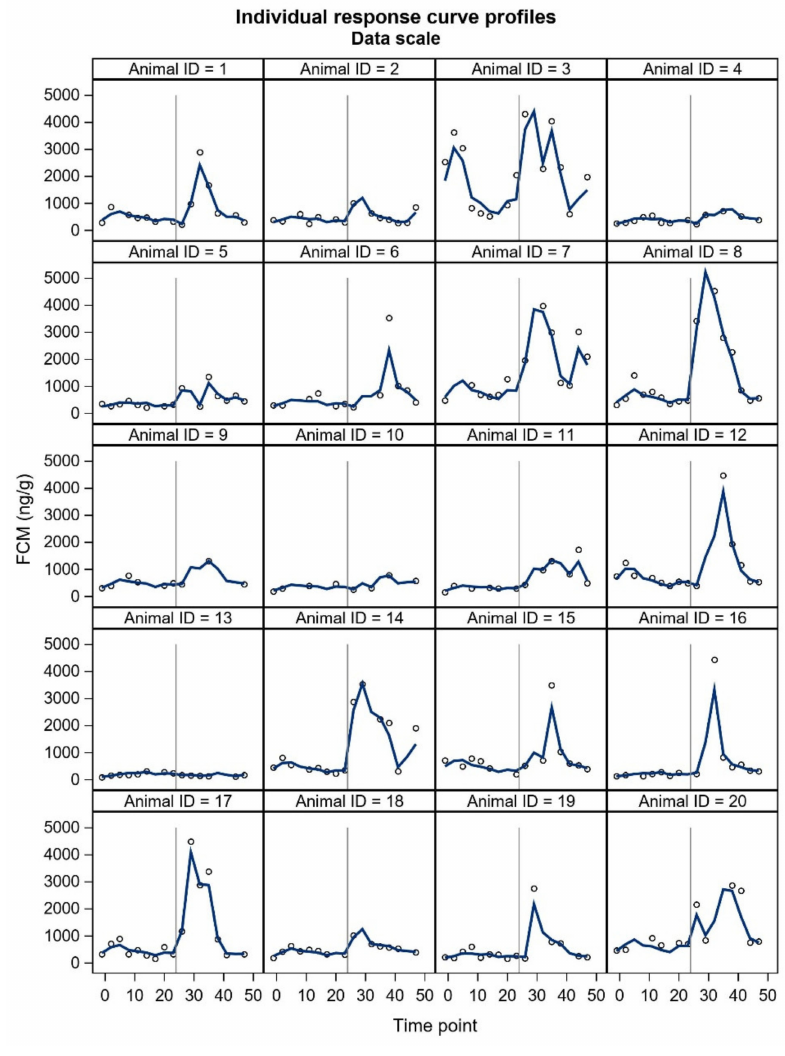
Figure 3. Individual curves of FCM concentrations based on the model estimation. The observations are presented with an open circle. The animal IDs from 1 to 9 represent males and the animal IDs from 10 to 20 represent females. The vertical grey line at time point 25 indicates the time of the ACTH